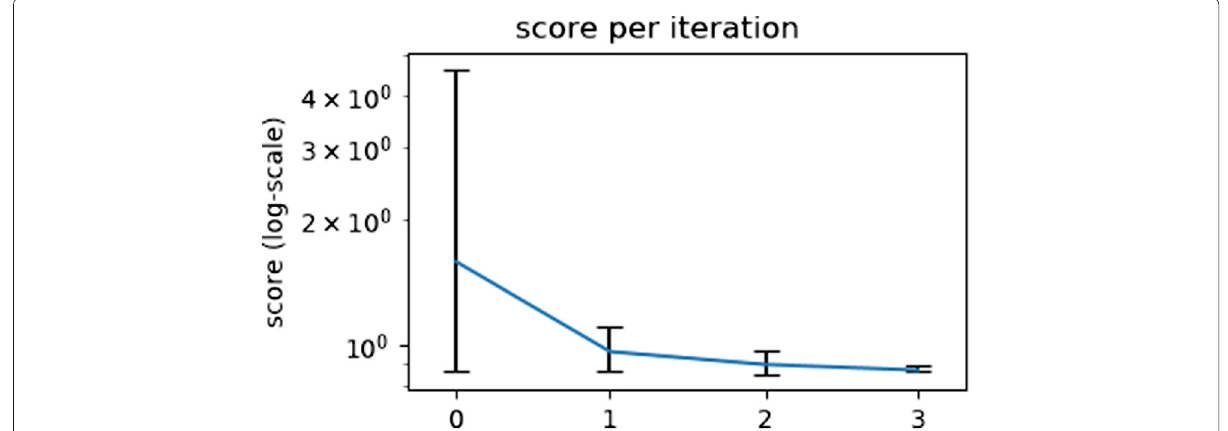
to Pegasus. This leads to a new sub-workflow (2) that per- forms the actual simulations and evaluates their results. Based on this, another DAG is planned and executed, which again leads to a new sub-workflow. This process repeats recursively (3) and more nested sub-workflows are generated and executed. Since it is not possible to know in advance when the workflow will end, even the final itera- tion (4) contains actions to plan and execute a new